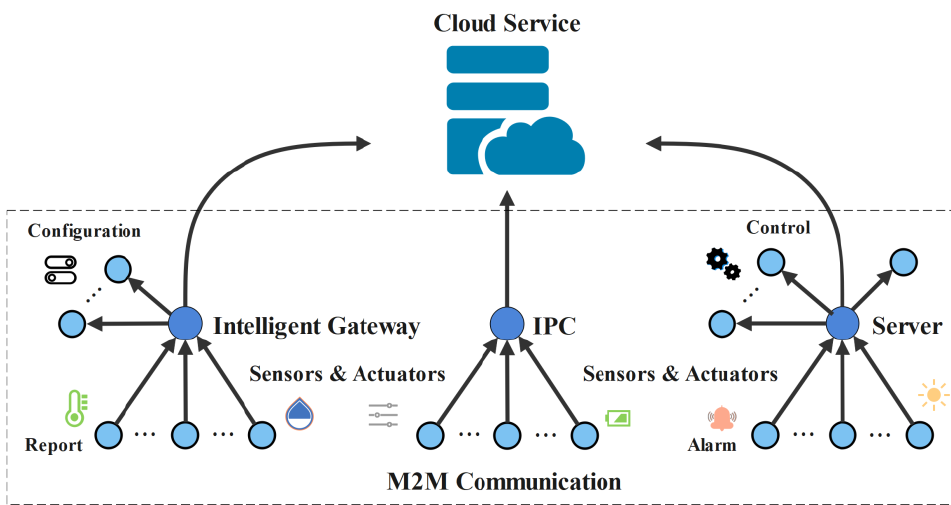
Figure 1. Illustration of M2M communication in IIoT.